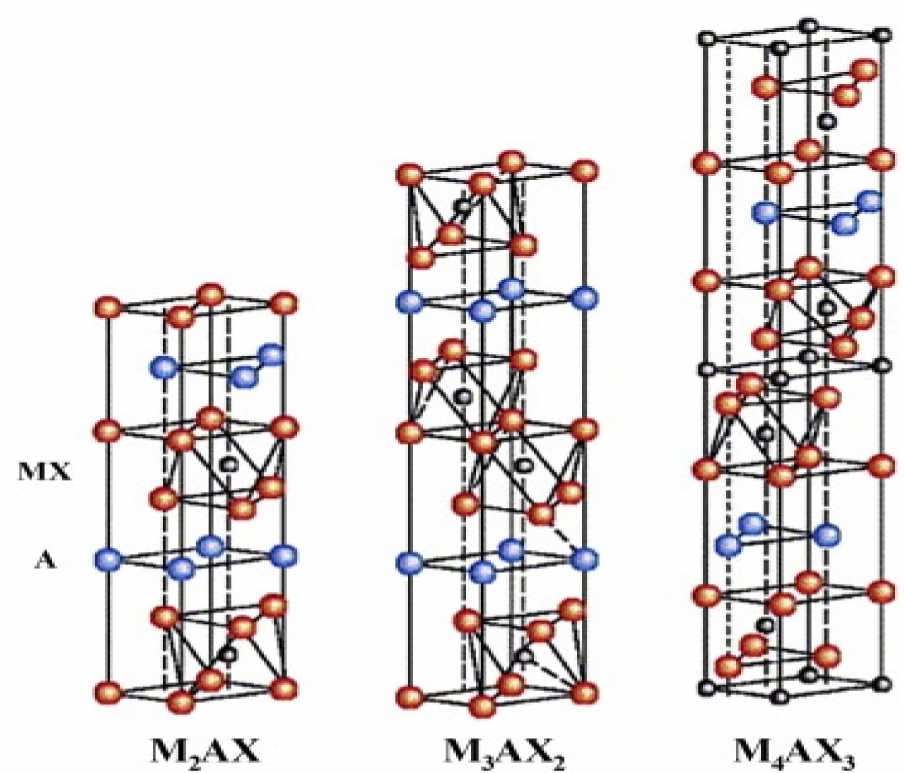
Figure 2. MAX phase P63/mmc symmetry. Blue balls denote the A layer atoms, red balls denote the M layer atoms, and gray balls occupying the octahedral site denote the X atoms. Reprinted with permission from ref. [11] (Eklund, Beckers, Jansson, Högberg, & Hultman, 2010). Copyright Elsevier Science